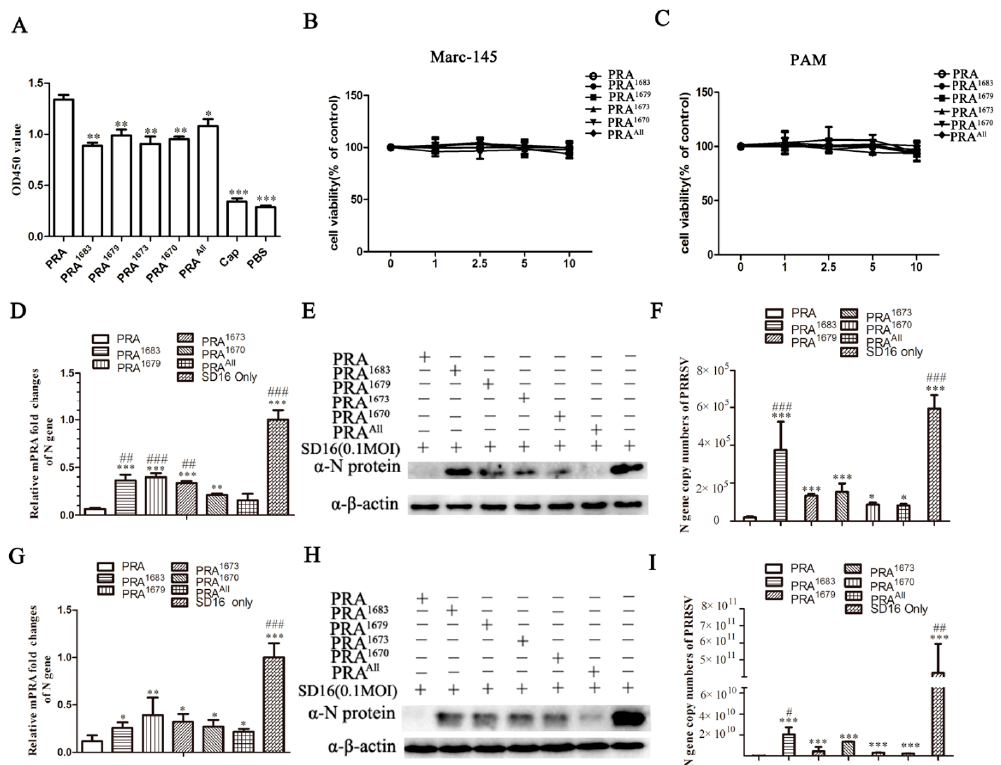
Figure 6. Impaired binding of Mab2-5G2 to PRA mutants correlates with reduced inhibition of PRRSV. ( A ) An ELISA-based virus capture assay performed by coating plates with PRA mutant proteins to capture free PRRSV virions followed by detection of captured PRRSV virions using PRRSV-convalescent swine serum and visualized by HPR-labeled goat anti-swine IgG secondary antibody. Wild-type PRA and recombinant PCV2 Cap protein served as positive control and negative control, respectively. ( B ) Potential cytotoxicity of PRA mutants (PRA 1683 , PRA 1679 , PRA 1673 , PRA 1670 , PRA all ) against